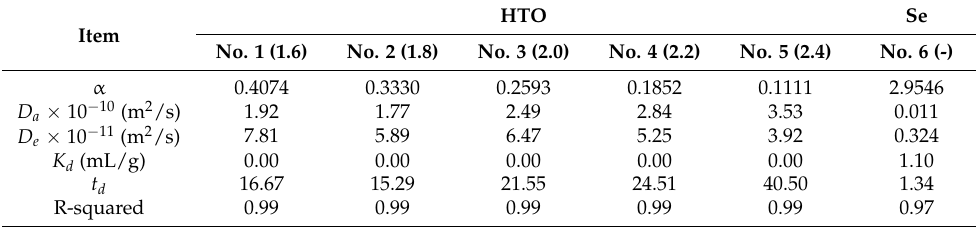
Figure 3. SEM–EDS analysis image of TMS clay rock: ( a ) SEM image of TMS clay particle; ( b ) EDS mapping analysis; ( c ) EDS spectra. Table 4. Diffusion parameters of HTO and Se in TMS clay rocks in through-diffusion